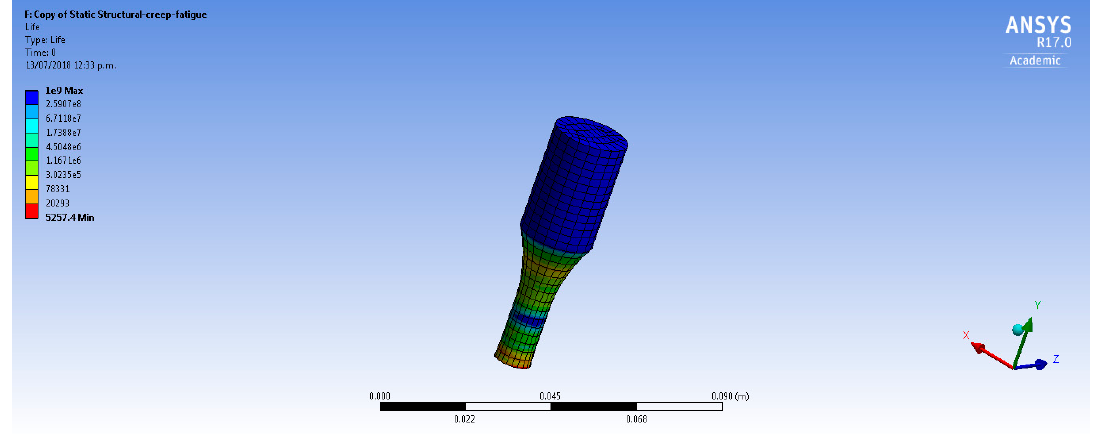
Figure A2. Fatigue life obtained at the creep-fatigue condition using conventional method.